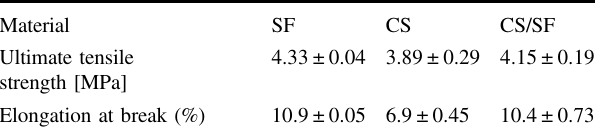
Table 1 The biomechanical properties of the electrospun SF, CS, and SF/CTS